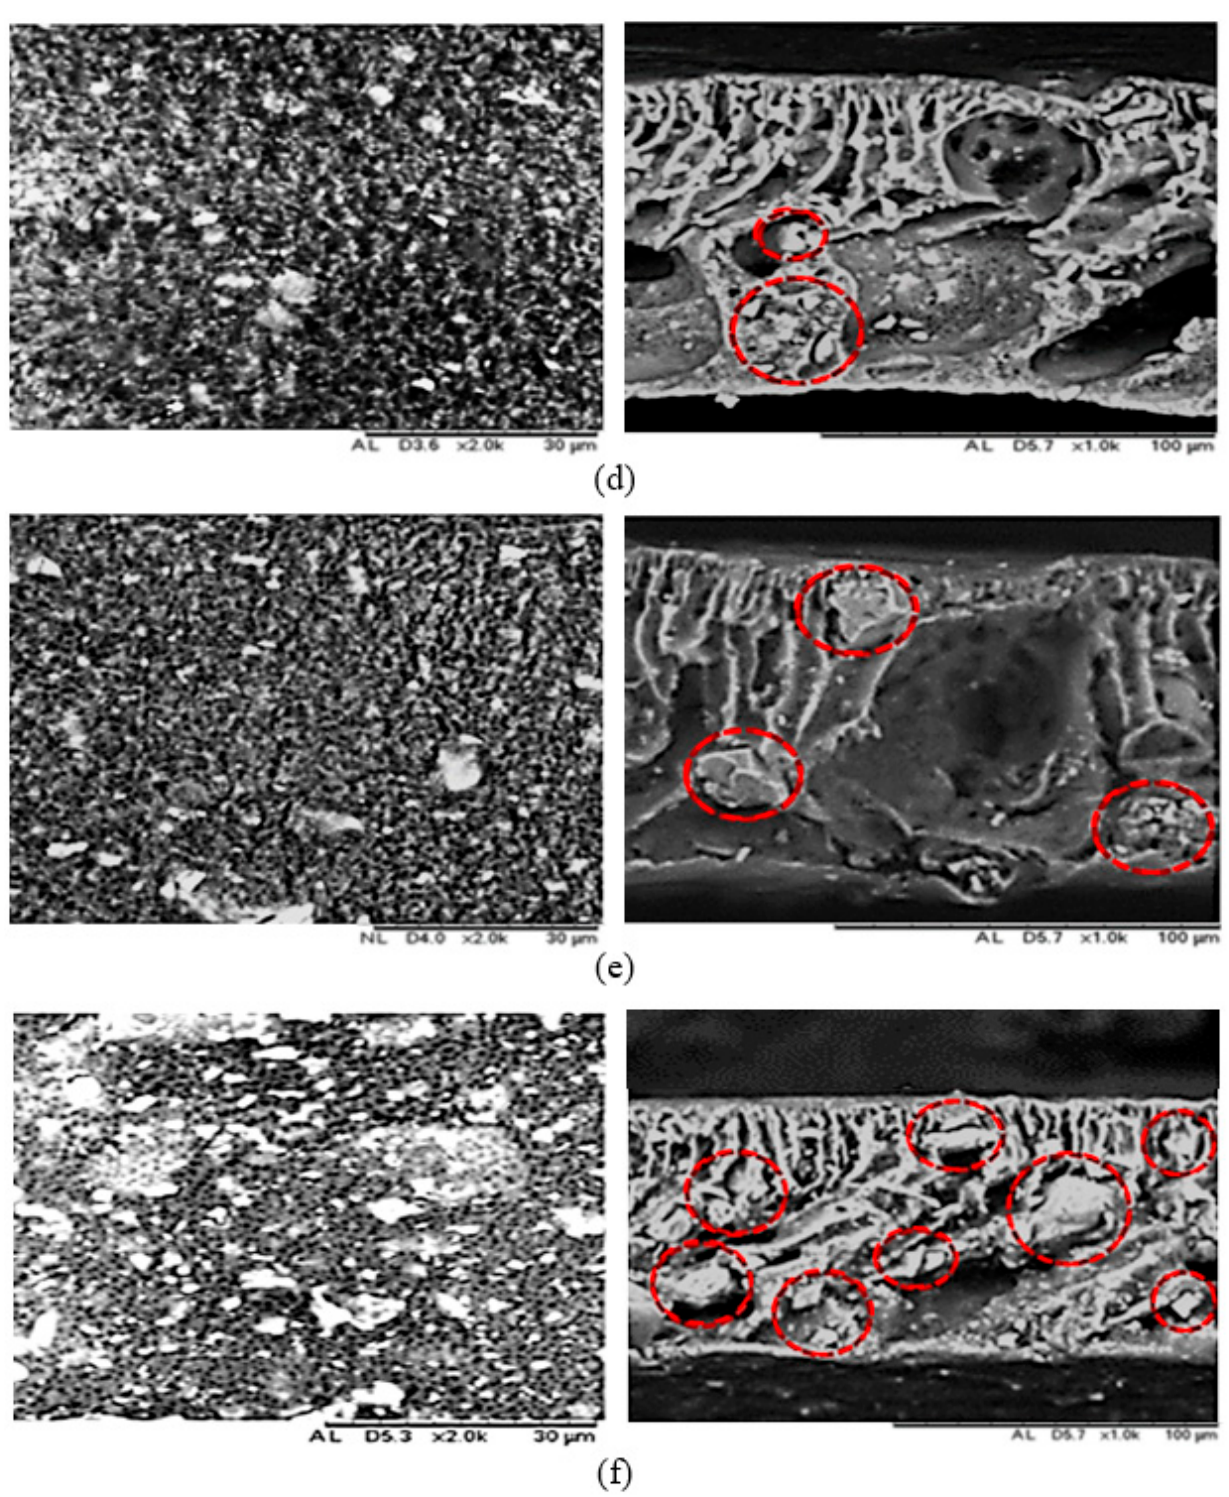
Figure 2. SEM images of top surface (left) and membrane cross-sectional morphology (right), ( a ) PES 0, ( b ) PES 1 and ( c ) PES 2, ( d ) PES 3, ( e ) PES 4, ( f ) PES 5. Red circles denote the aggregate of nanoparticles.